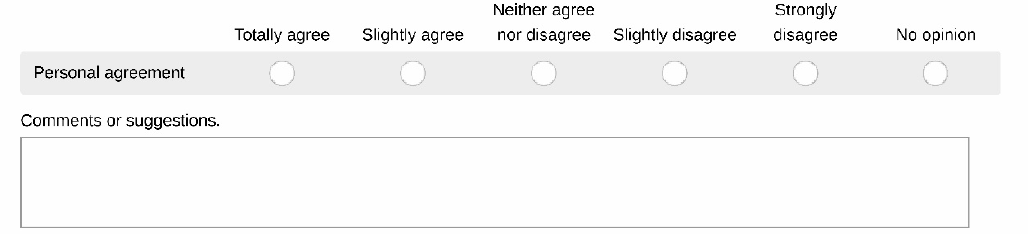
FIGURE A2-2 Layout of a question in the 2 nd round of Delphi